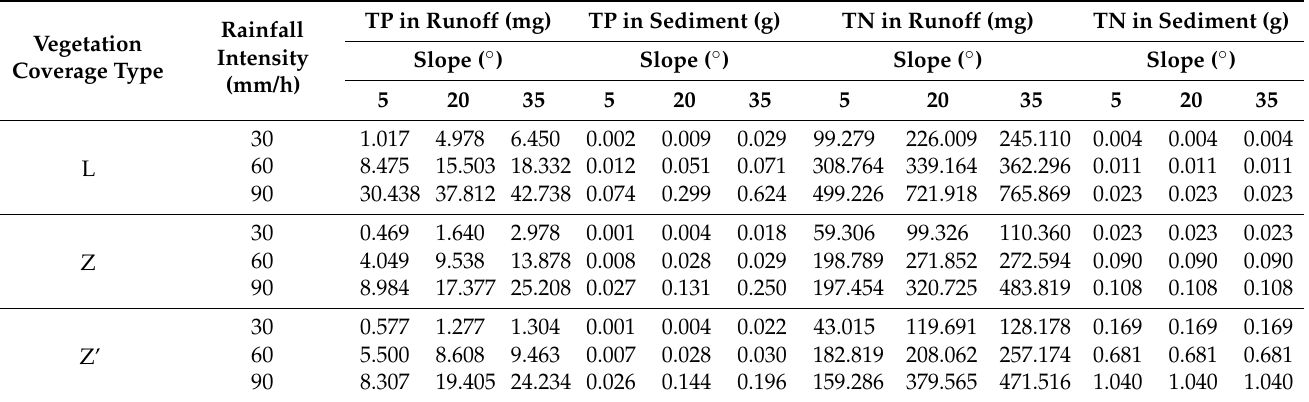
Table 2. Total loss of TN and TP in runoff and sediment under different combinations of